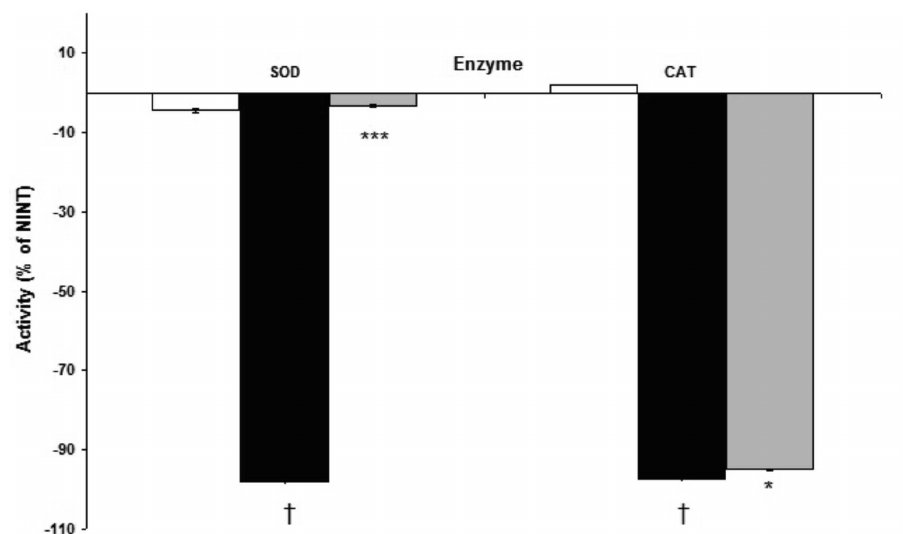
FIGURE 2 - The first line of the antioxidant defense enzymes in Plasmodium berghei -infected erythrocytes treated with clotrimazole (CTZ). Results are expressed as the mean ± SEM of the percentage of activity compared to non-infected and non-treated erythrocytes (NINT) (basal line). SOD: superoxide dismutase; CAT: catalase; NI + CTZ: non-infected red blood cells and treated with CTZ (white bars); I: infected erythrocytes (black bars); I+CTZ: infected red blood cells and treated with CTZ (gray bars); † p <0.001 compared to NINT; * p <0.05 and *** p <0.001 compared to